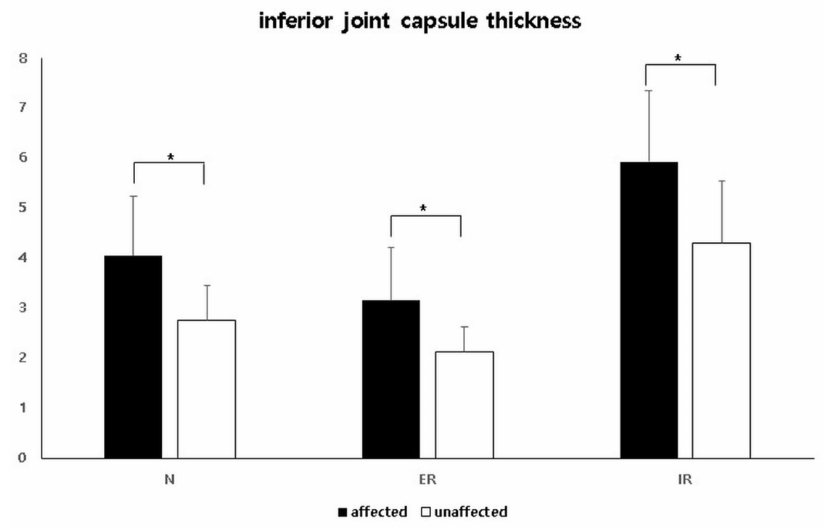
Figure 4. Comparison of the inferior joint capsule thickness between the affected and unaffected shoulders in three different positions. N, neutral position; ER, externally rotated position; IR, internally rotated position. * Statistically